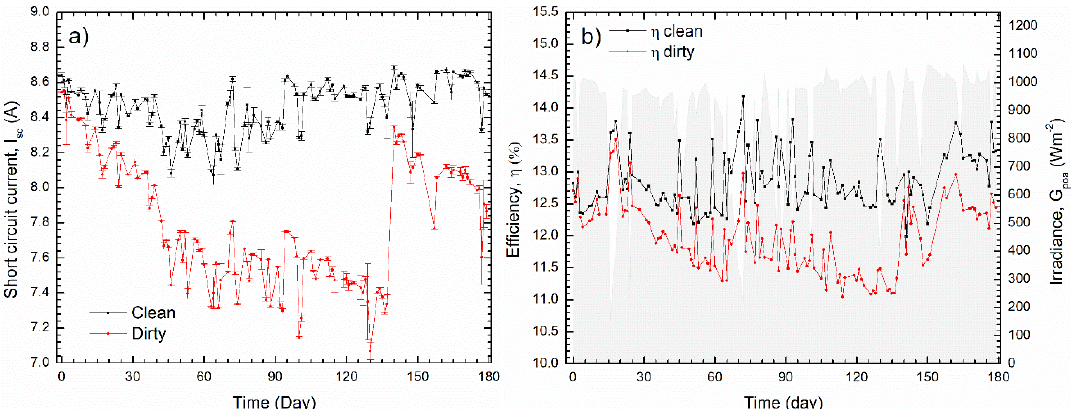
Figure 12. ( a ) Short-circuit current and ( b ) module efficiency for the measurement period, considering rainfall.